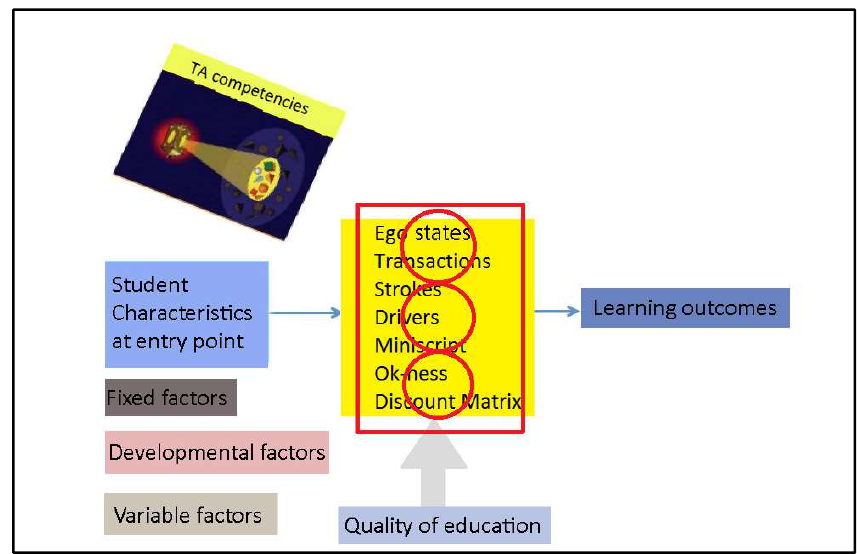
Figure 1: An Integrated Model